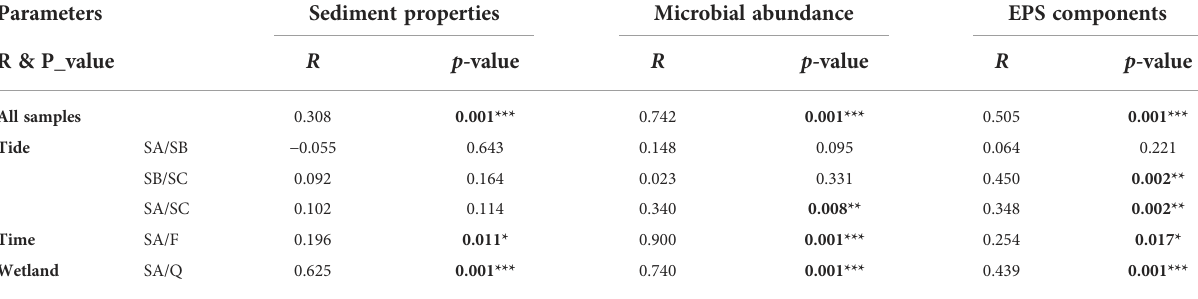
TABLE 1 ANOSIM results based on Bray – Curtis distance showing the in fl uences of tide, season, and wetland on sediment properties, microbial abundance, and EPS components.